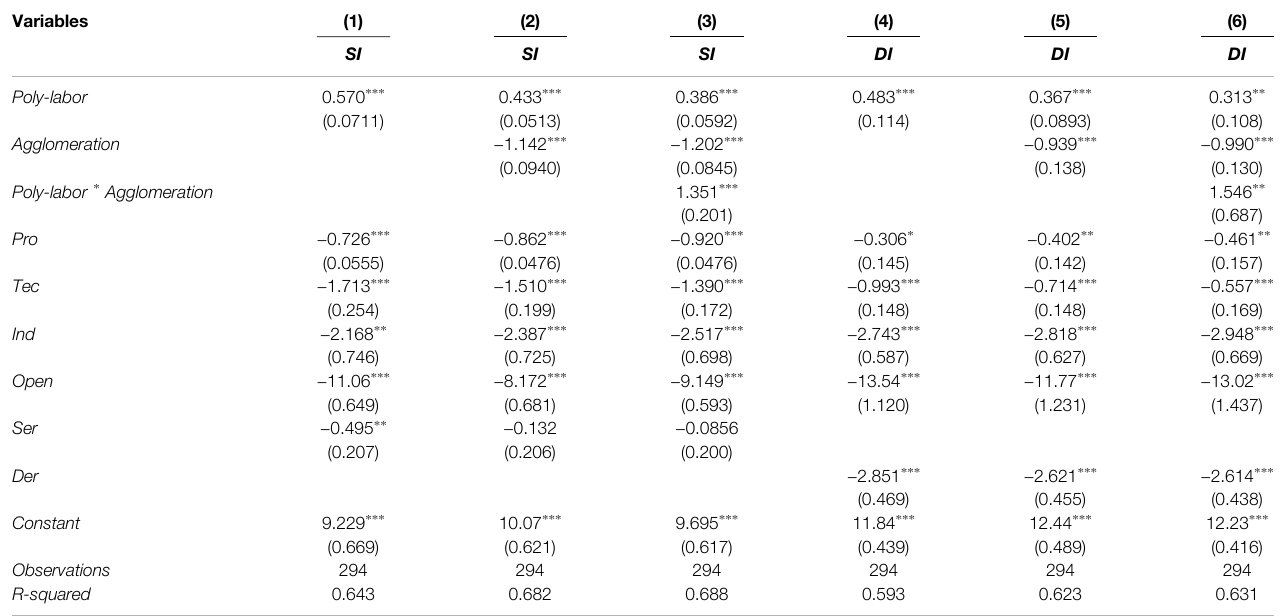
TABLE 4 | The interactive emission reduction effect of labor force polycentricity and agglomeration.